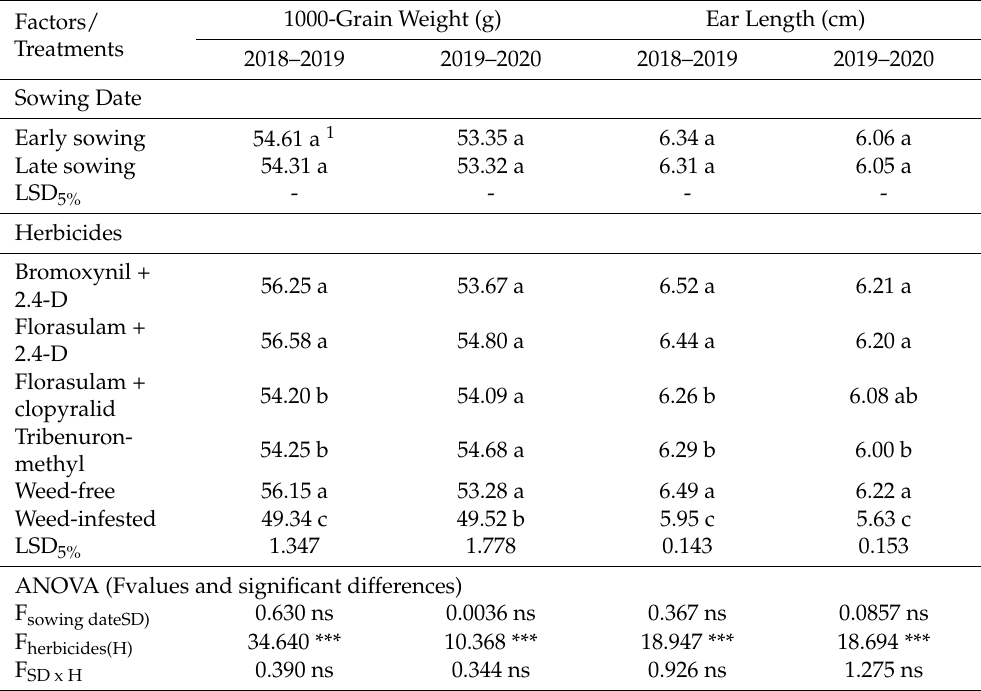
Figure 3. The dry biomass (kg ha − 1 ) of the durum wheat crop as affected by the sowing date (early and late sowing) and the herbicide treatments (bromoxynil + 2.4-D, florasulam + 2.4-D, florasulam + clopyralid, tribenuron-methyl, weed-free, and weed-infested). Means followed by the same letters do not significantly differ with Fisher’s least significant difference (LSD) test. Error bars indicate the LSD values. Table 6. Ear length (cm) and 1000-grain weight (g) as affected by the sowing date (early and late sowing) and the herbicide treatments (bromoxynil + 2.4-D, florasulam + 2.4-D, florasulam + clopyralid, tribenuron-methyl, weed-free, and